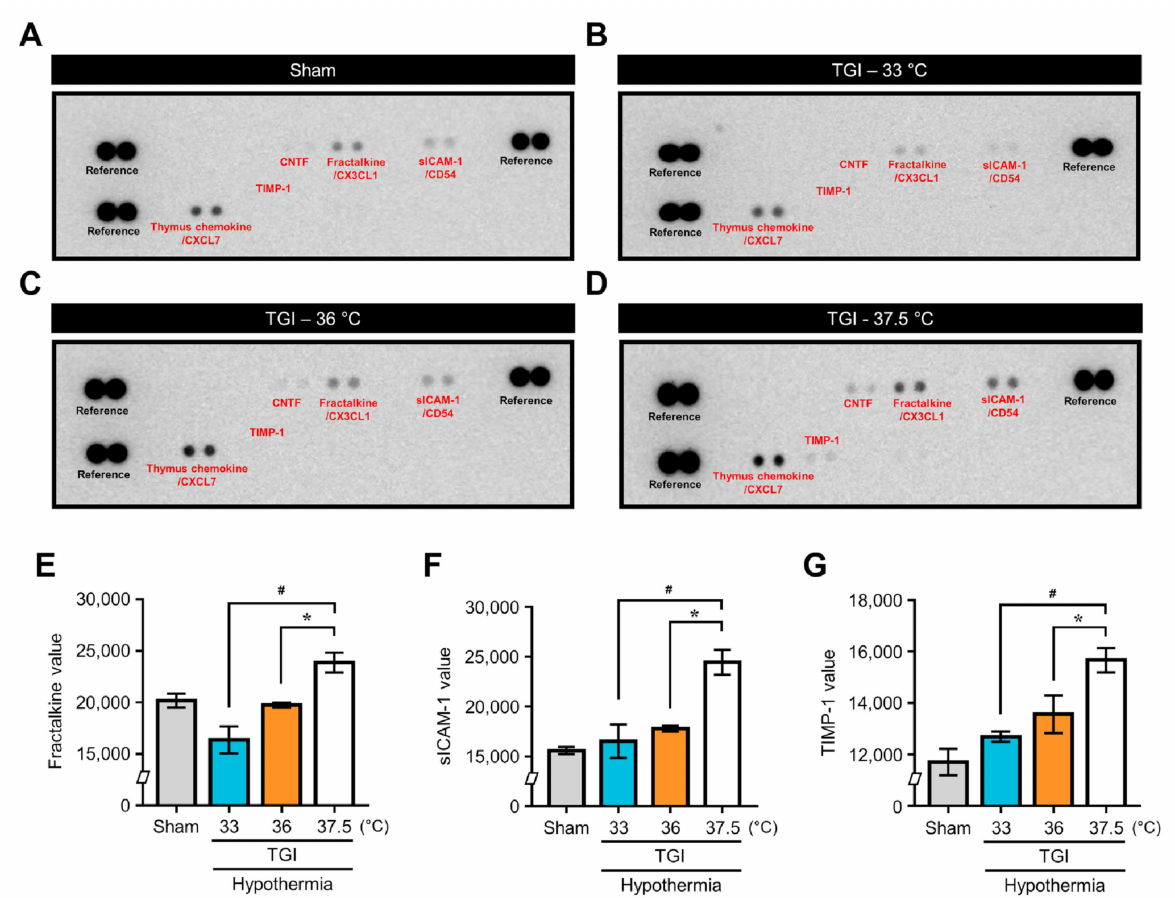
Figure 6. Cytokine array screening of the normal temperature and hypothermic paradigms of TGI. ( A – D ) Representative chemiluminescent images show the proteome profiler array at normal temperature and TTM conditions at 24 h after TGI. Selected cytokines involving ciliary neurotrophic factor, fractalkine/CX3CL1 (chemokine ligand 1), slCAM-1/CD54, thymus chemokine/CXCL7 (chemokine ligand 7), and tissue inhibitor of metalloproteinases 1 are indicated in the box, and compared with sham or TGI to normal temperature at 37.5 ◦ C, TTM at 33 ◦ C and 36 ◦ C. ( E – G ) Analyzed value of the selected cytokines (fractalkine/CX3CL1, slCAM-1/CD54, tissue inhibitor of metalloproteinases 1) displayed by a representative bar graph. Expression of these cytokines was remarkably attenuated by TTM at 33 ◦ C and 36 ◦ C after TGI (one way-ANOVA, multiple comparison following Bonferroni adjustment. Sham, n = 3; TGI + 33 ◦ C, n = 3; TGI + 36 ◦ C, n = 3; TGI + 37.5, n = 3. * p and # p <